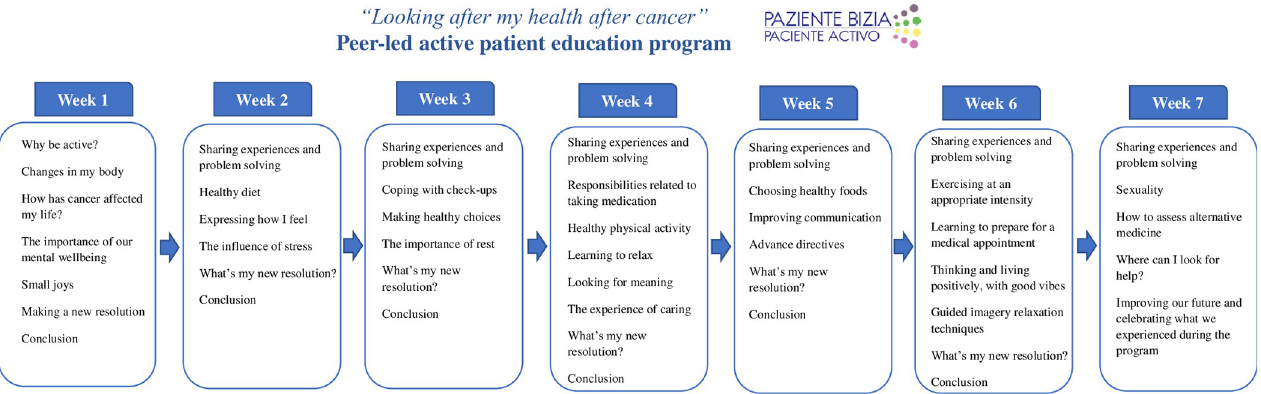
Fig 1. Structure and content of the “Looking after my health after cancer” peer-led active patient education program.